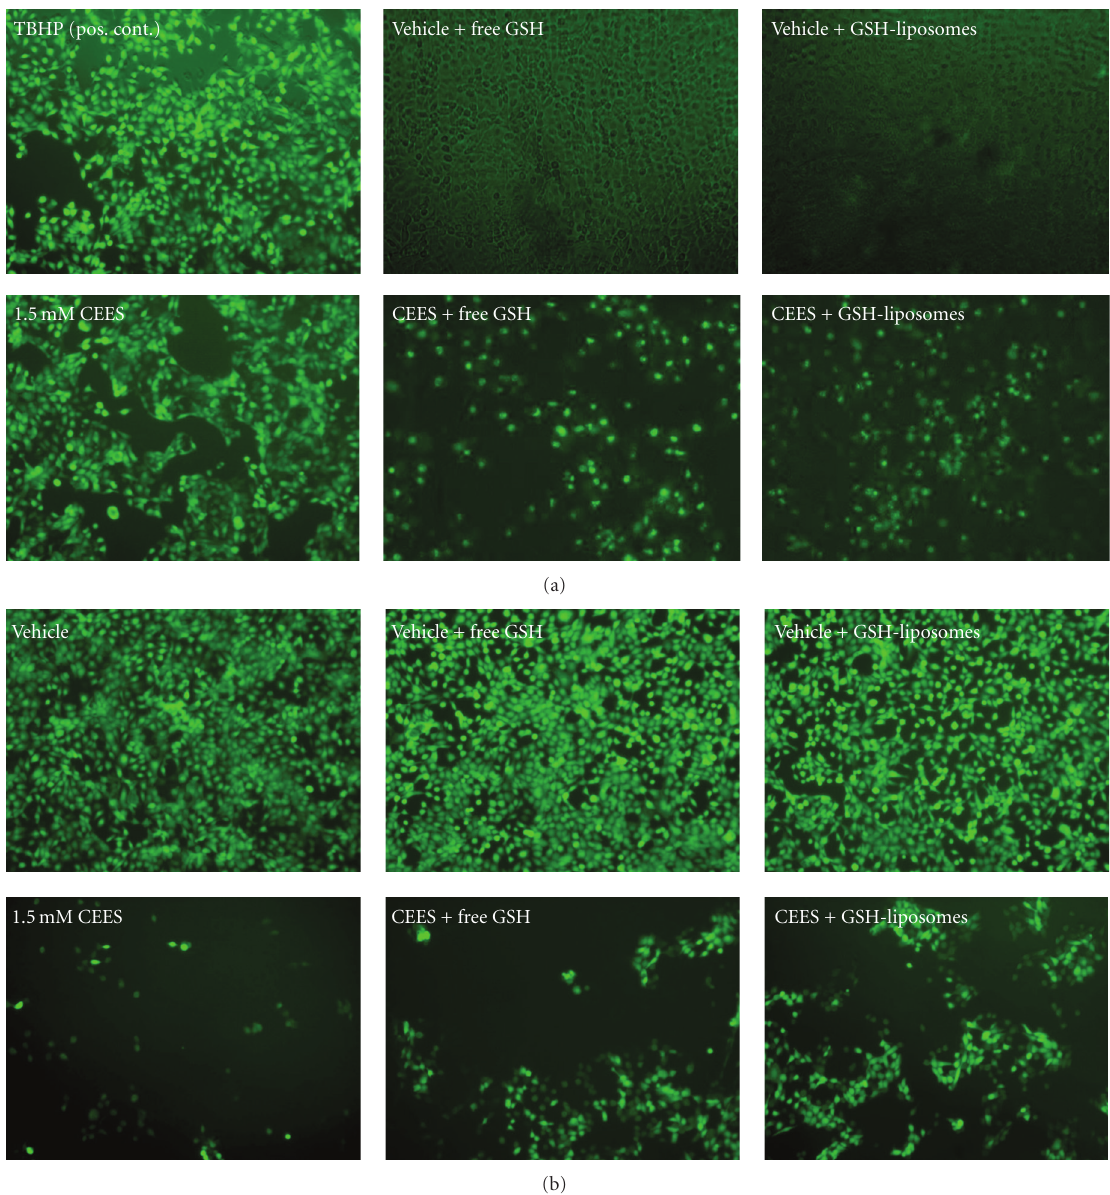
Figure 2: GSH prevents ROS generation and thiol depletion in HaCaT cells . HaCaT cells were treated with vehicle (1% DMSO) or 1.5 mM CEES (as indicated) in the presence or absence of “free” GSH or GSH-liposomes (as indicated), simultaneously. Cells were incubated at 37 ◦ C for 6 hours and then stained with 10 μ M carDCFH-DA to monitor ROS generation (a); alternatively, cells were incubated at 37 ◦ C for 18 hours and then stained with 10 μ M CMF-DA to access intracellular nonprotein thiols (b). 100 μ M TBHP (tert-butyl hydroperoxide) was used as a positive control (to induce oxidative stress). Live cells were photographed under a fluorescent microscope (200x magnification) equipped with a standard FITC filter. Vehicle-treated sample stained with carDCFH-DA (a) shows merged images (green fluorescence and phase contrast) in order to visualize live cells in the absence of